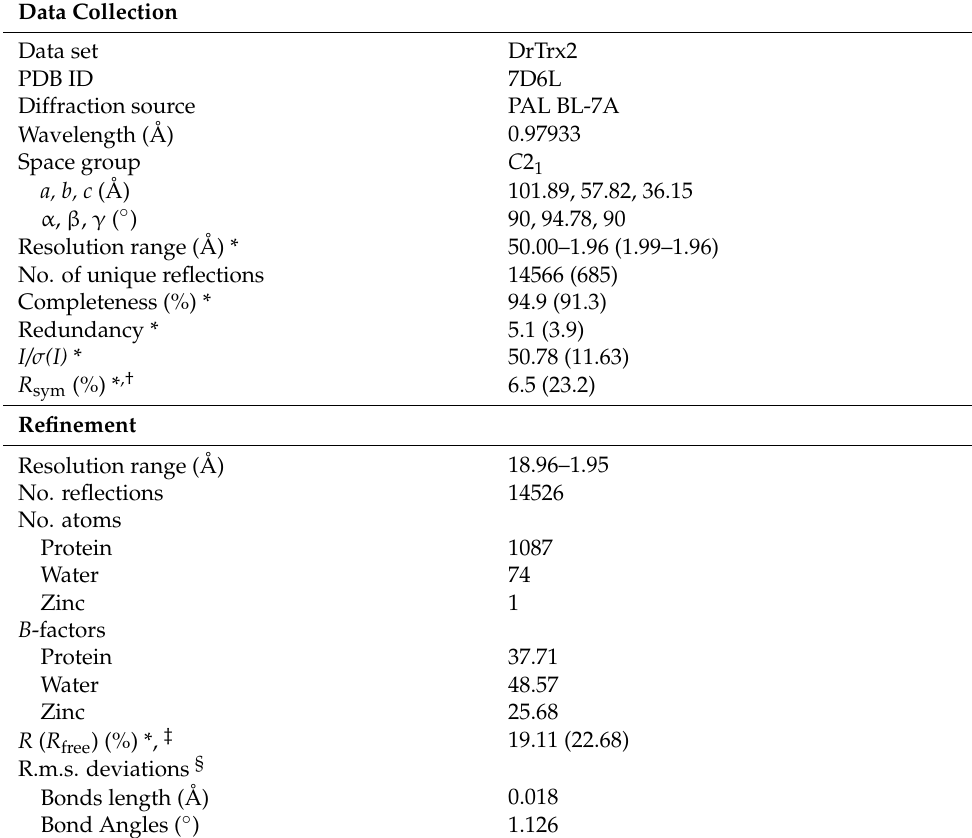
Table 1. Data collection and refinement